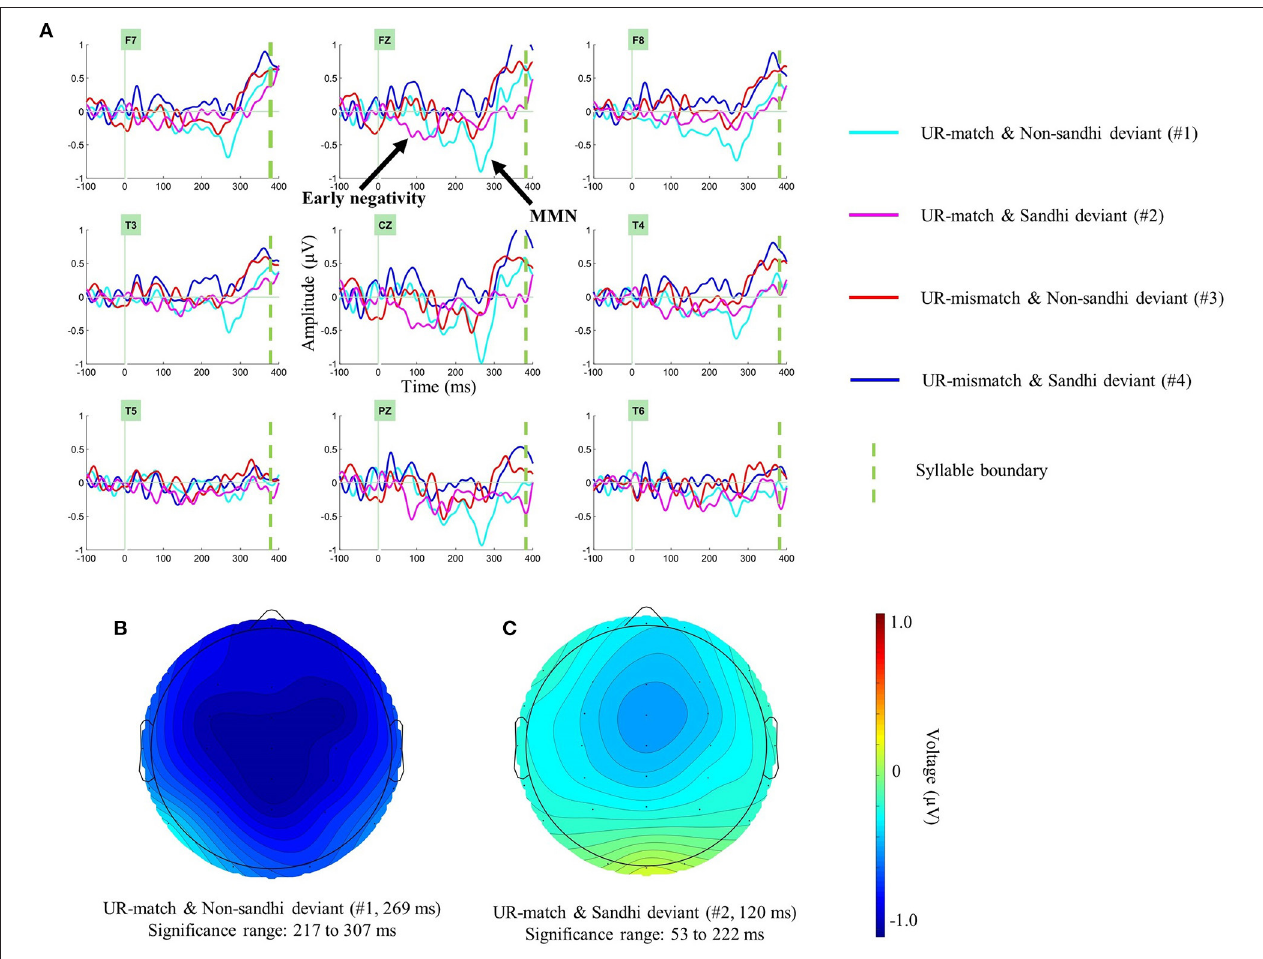
FIGURE 3 | Examining the presence of segmental MMN in the first syllable (S1). Panel (A) shows identity difference waves (deviant minus standard) over selected electrodes in the first syllable. Panel (B) shows the topography of the significant negative cluster in the UR-match and Non-sandhi deviant Condition (#1), at a visually identified negative peak (269ms). Panel (C) shows the significant negative cluster in the UR-match and Sandhi deviant Condition (#2), at a visually identified negative peak (120ms). Only the negative cluster in the UR-match and Non-sandhi deviant Condition (#1) is interpreted as